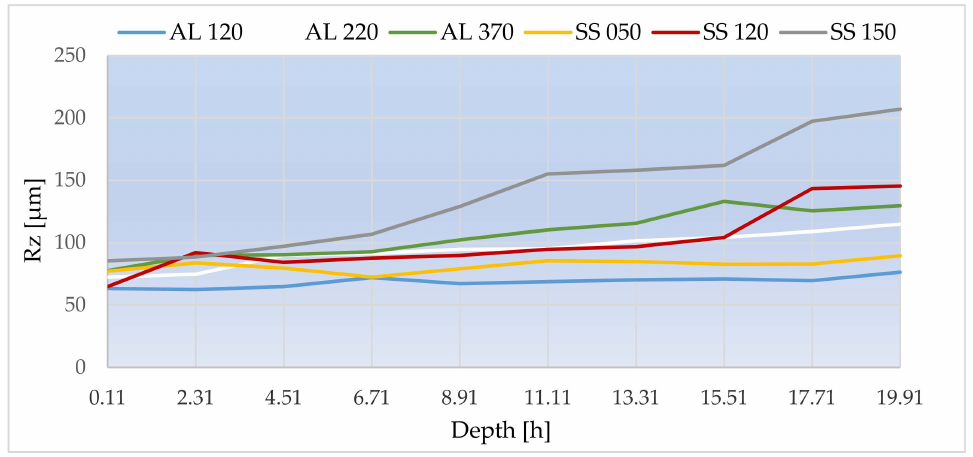
Figure 10. The graphical dependence of Rz on the measurement depth for AL120, AL220, AL370 and SS050, SS120,